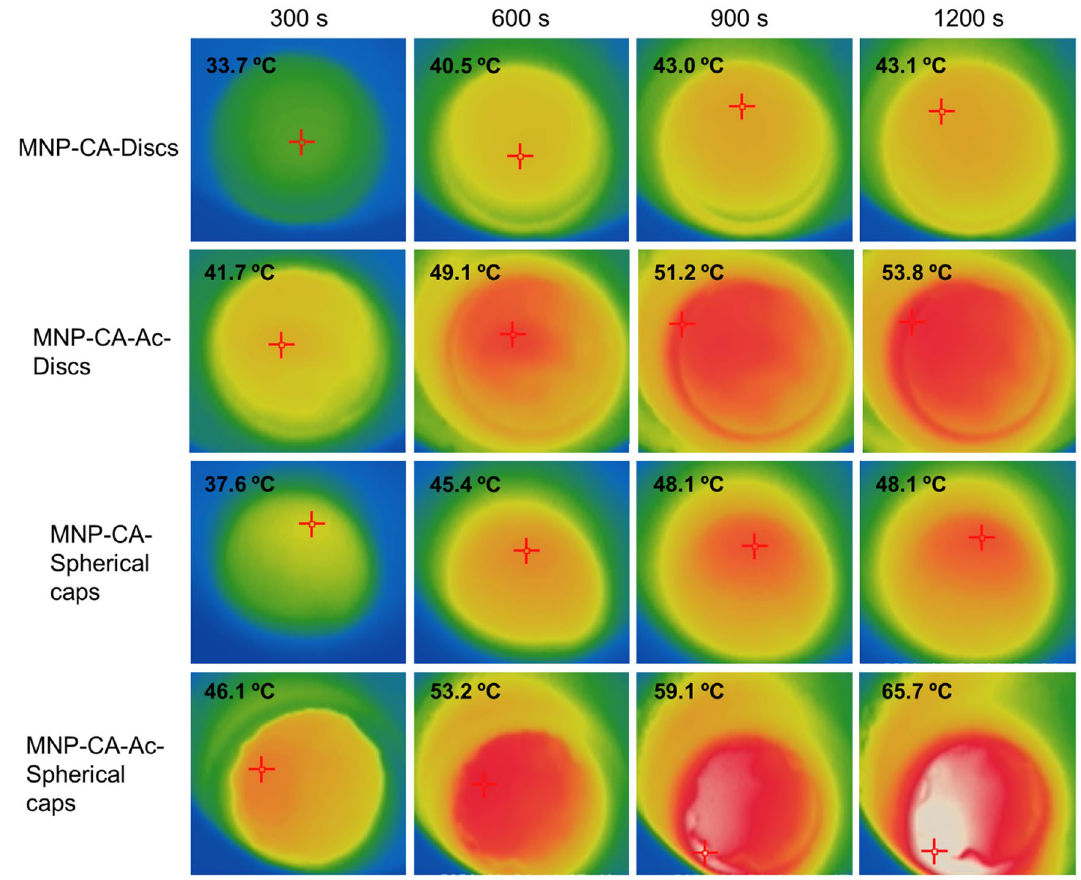
Figure 7. Thermal images indicating magnetic hyperthermia mediated temperature increase of disc- shaped and spherical cap shaped gels with and without acetaminophen coating (MNP-CA and MNP-CA-Ac respectively) over time. The hyperthermia set up consisted of a copper coil and a Hikvision ds-2tp21b thermal imaging camera. The coil was heated under 19.95 V with a 14 A (AC) current at a frequency of 0.816 MHz. Gels were kept in the center of the coil on a Teflon container and subject to heating while thermal images were taken every 10 s for 20